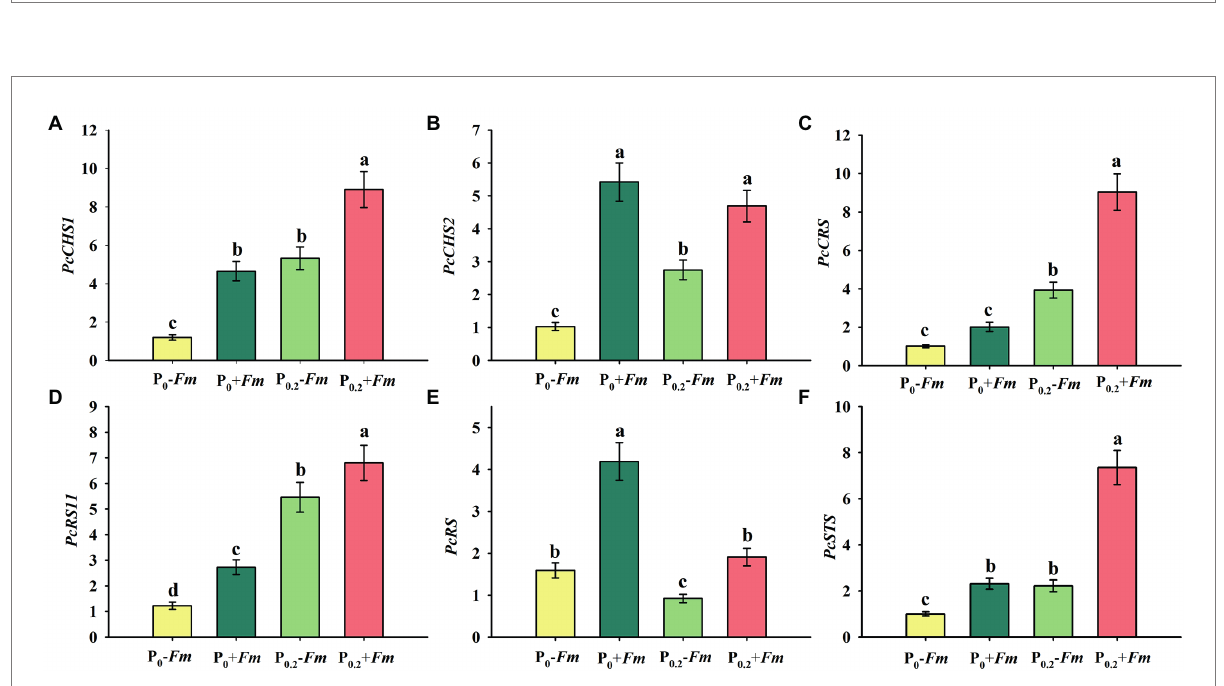
FIGURE 5 Changes in root PcCHS1 (A) , PcCHS2 (B) , PcCRS1 (C) , PcRS11 (D) , PcRS (E) , and PcSTS (F) of Polygonum cuspidatum by Funneliformis mosseae and P supply. Data (means ± SD, n = 3) followed by different letters above the bars indicate significant ( p < 0.05) differences among treatments. + Fm , inoculation with F. mosseae ; − Fm , inoculation without F . mosseae ; P 0 , 0 M P; P 0.2 , 0.2 M P; P, phosphorus; CHS, chalcone synthase; RS, resveratrol synthase; STS, stilbene synthase; CRS, supposed stilbene synthase; RS11, resveratrol-forming stilbene synthase